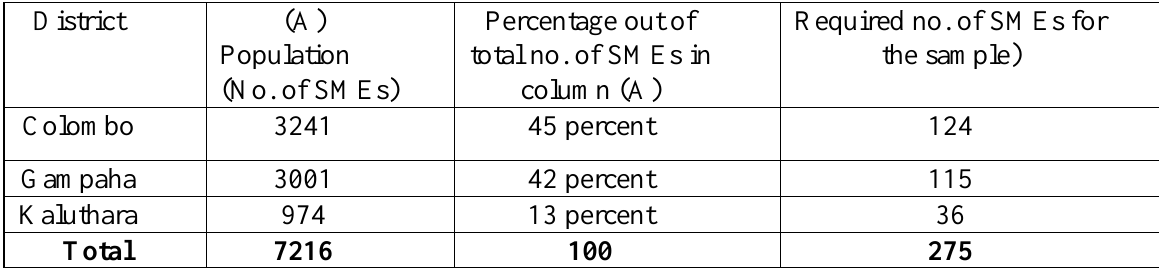
Required no. of SMEs for the